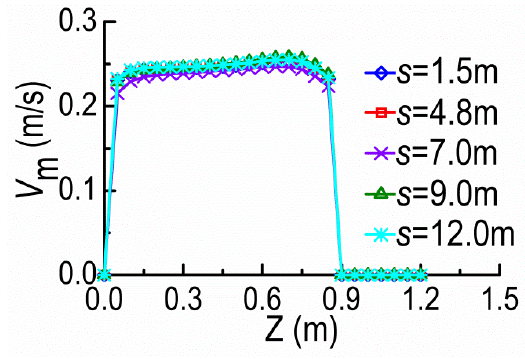
Figure 9. V m along Z-direction at the cross-section A.